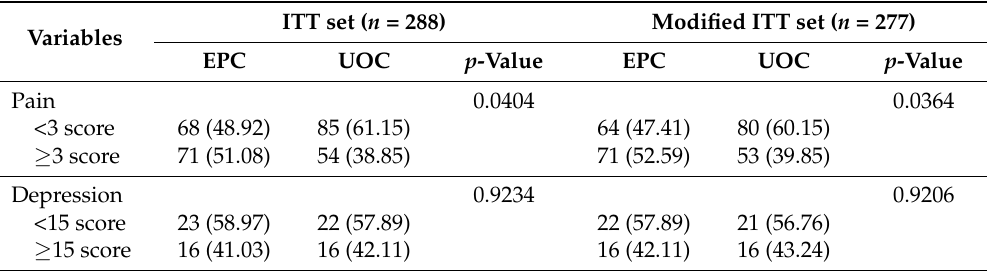
Table 3. Proportion of patients in the EPC and UOC groups with brief pain inventory (BPI) worst